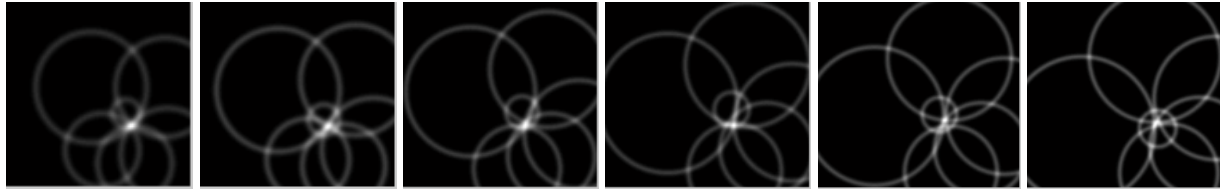
Figure 5. Voting results in the optimal scale layer. Each one corresponds to the frames shown in Figure 4(d).